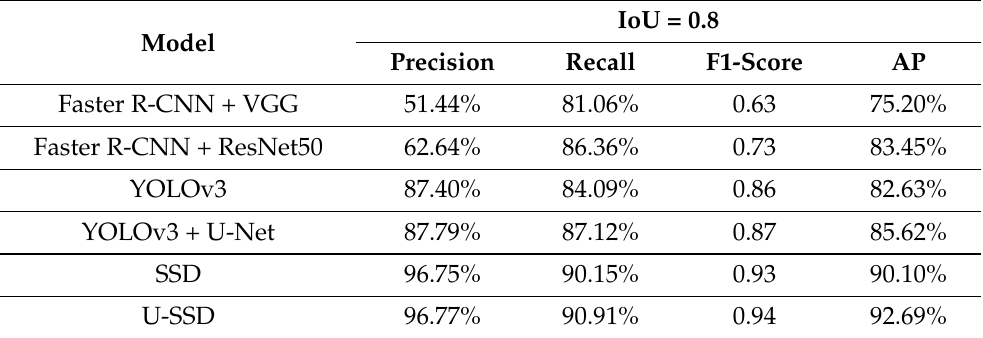
Table 3. The comparison at IoU = 0.8 on our dataset.